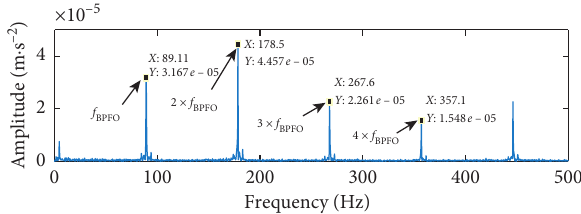
Figure 19: Simulated signal for ER-16K under